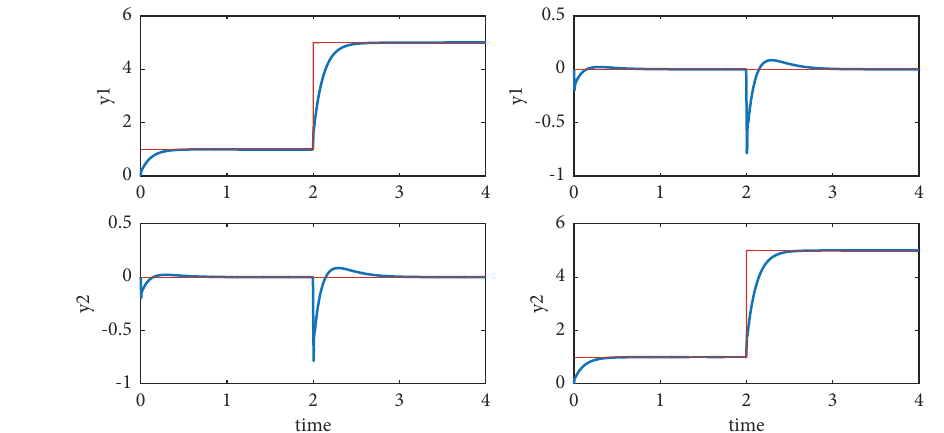
Figure 10: System step response in the frst